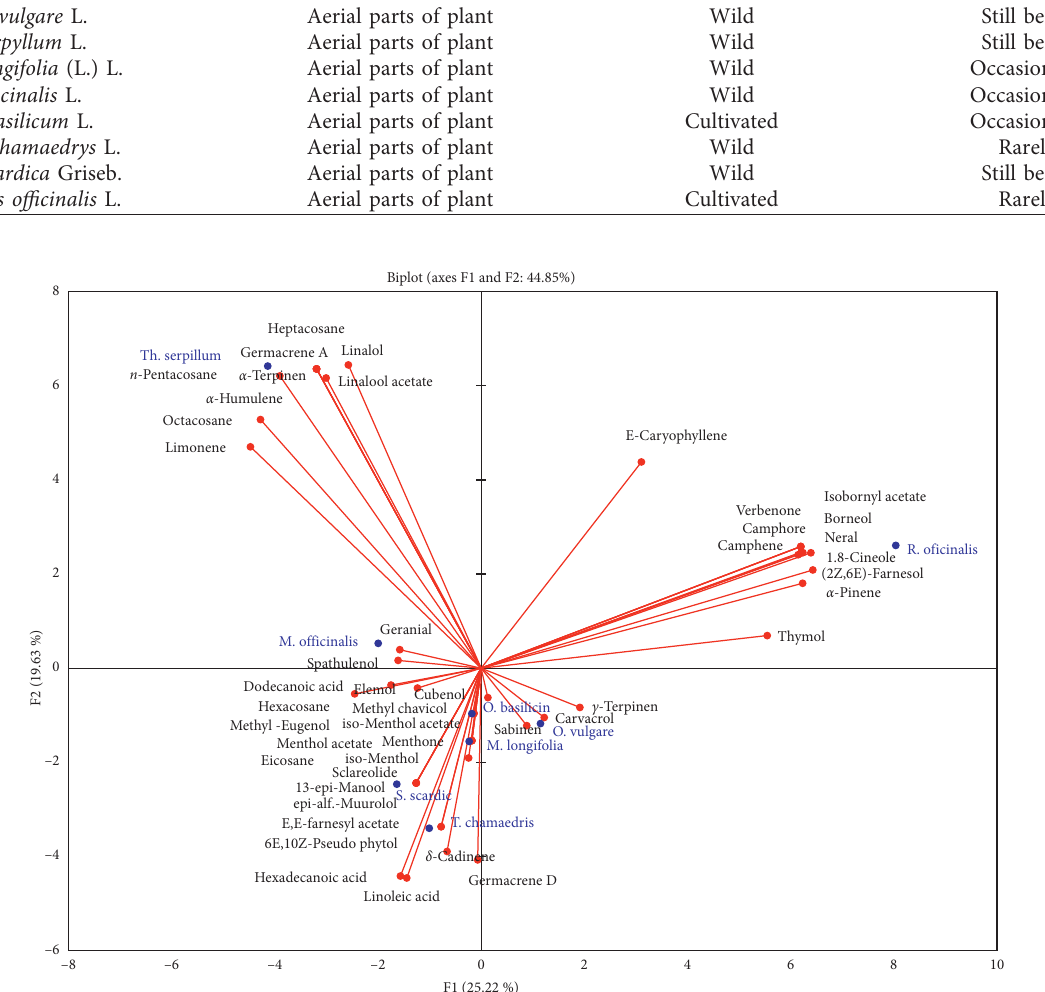
Figure 1: Diagram generated from the Principal Component Analysis of volatile compounds found in 8 plant species of the Lamiaceae family traditionally used as